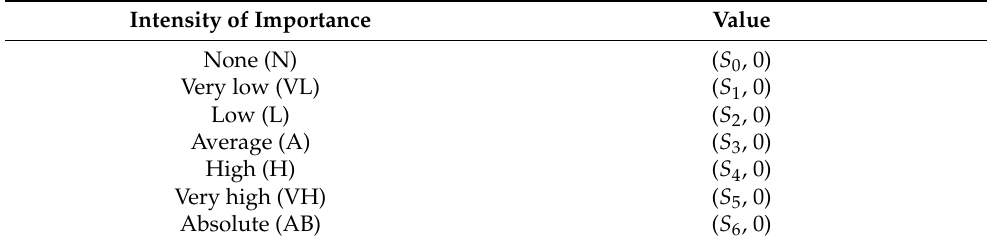
Table 3. Linguistic variables for the ratings of